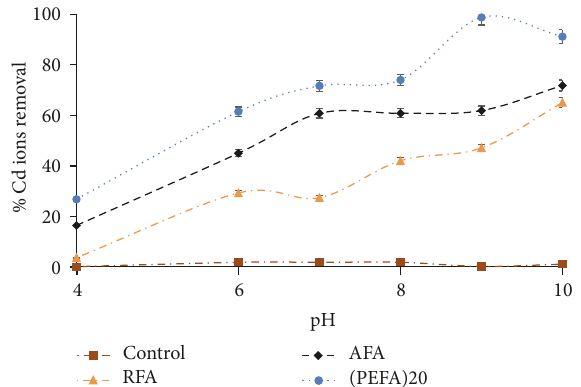
Figure 9: The influence of pH on the removal efficiency of Cd (II) ions on FA based adsorbents (RFA, AFA, and PEFA) as a function of 2 mg/L metal ion concentration, 4g/L adsorbent dosage, 50 mL volume of aqueous solution, mixing rate of 150rpm, 15min contact time, and 298 K temperature.